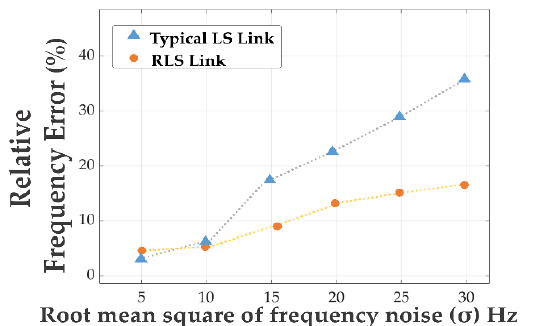
Figure 14. Performance of the RLS